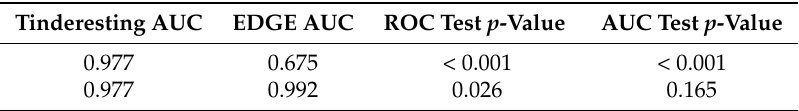
Figure 8. Precision–recall curves of tinderesting and EDGE. The precision–recall curves illustrate the same overall results as the ROC curves. This indicates that the performance is not due to class imbalance artifacts. Table 1. Statistical comparison of the multiple ROC curves and corresponding AUC values with the Venkatraman [19] and DeLong [20] tests,